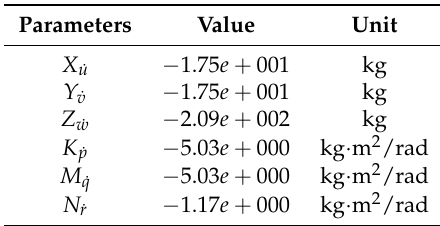
Table 3. Added Mass